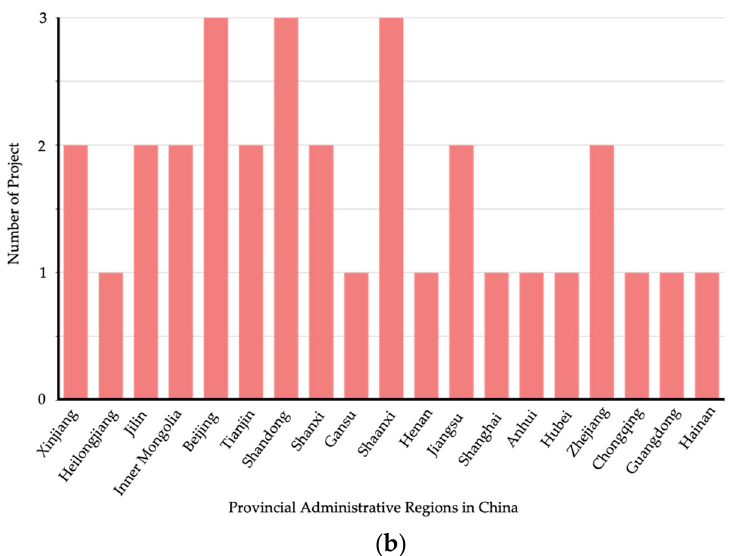
Figure 2. Distribution of CCUS projects in China [50]. ( a ) CCUS project type distribution in China; ( b ) CCUS project location distribution in China.